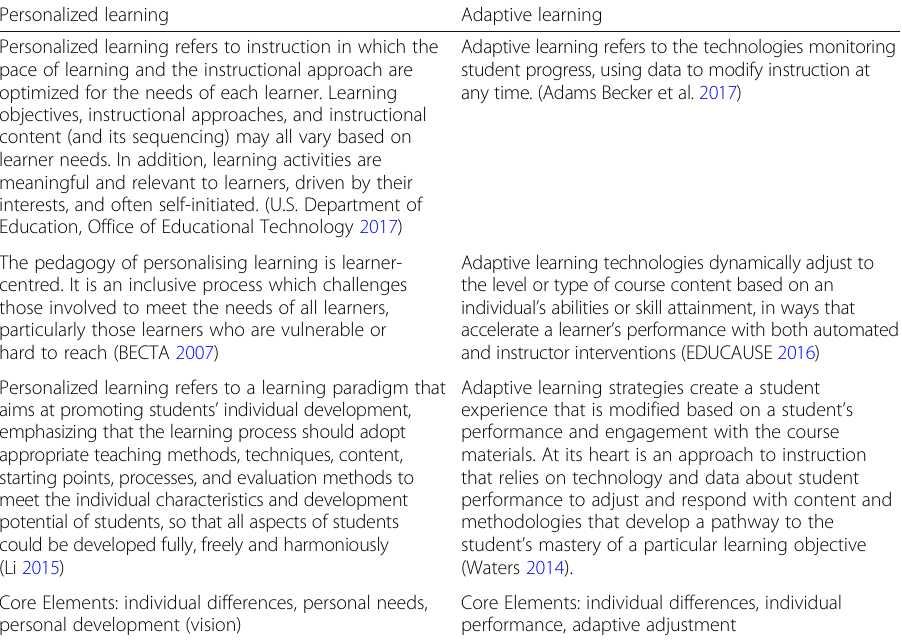
Table 1 Comparison between Personalized Learning and Adaptive Learning Personalized learning Adaptive